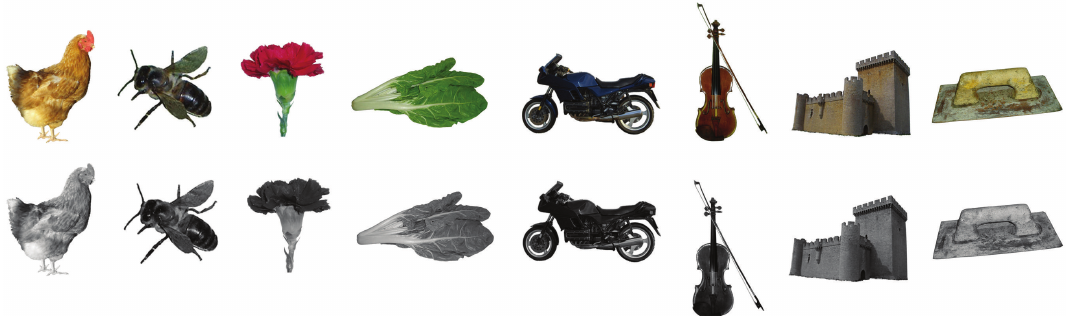
Figure 1: Colour and greyscale versions of items from the Nombela Naming Test. From left to right: hen, bee, carnation, chard, motorbike, violin, castle, and trowel.